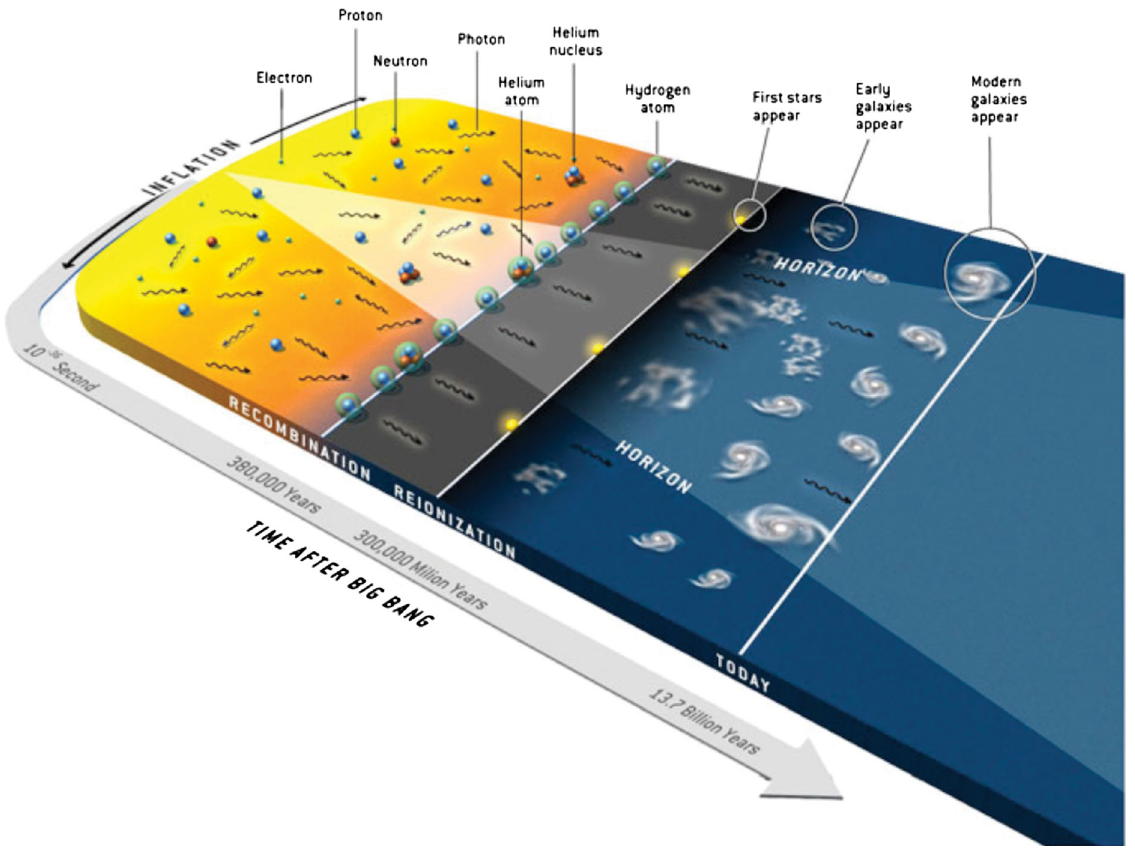
FIG. 18. Timeline of the Universe representation as shown in a popular science article. Image credit: Hu and White